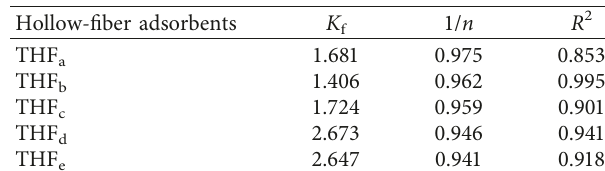
Table 3: Freundlich isotherm analysis of hollow-fiber adsorbents with different